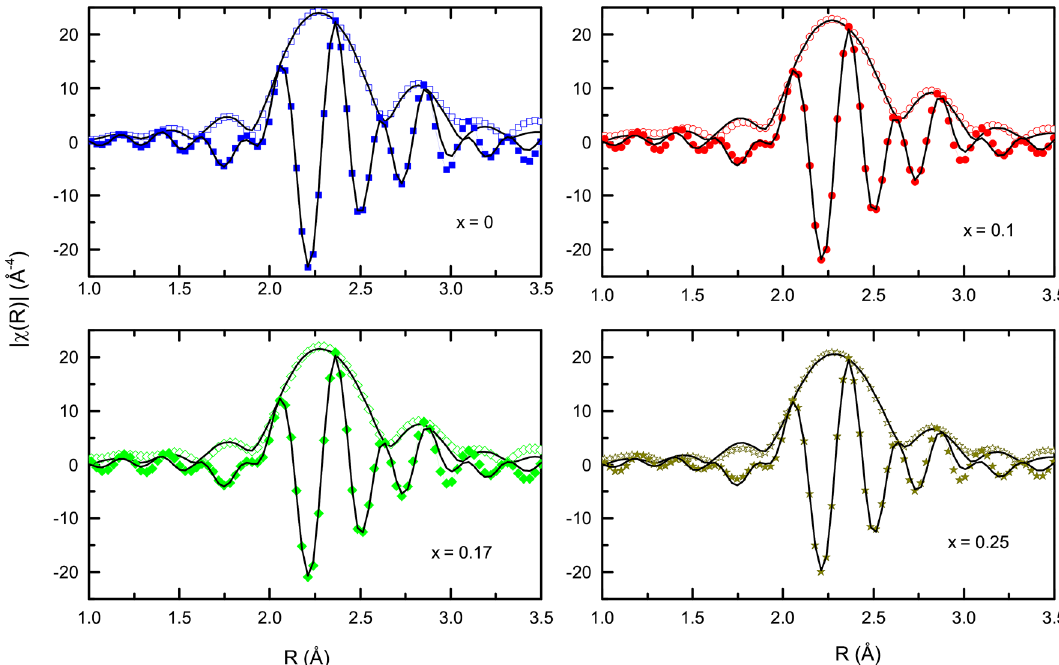
Figure 5. Fitting to the magnitude (hollow symbols) and real component (filled symbols) of Fourier transform 3 of k weighted Fe K-edge EXAFS spectra of Fe 2 Ti 1